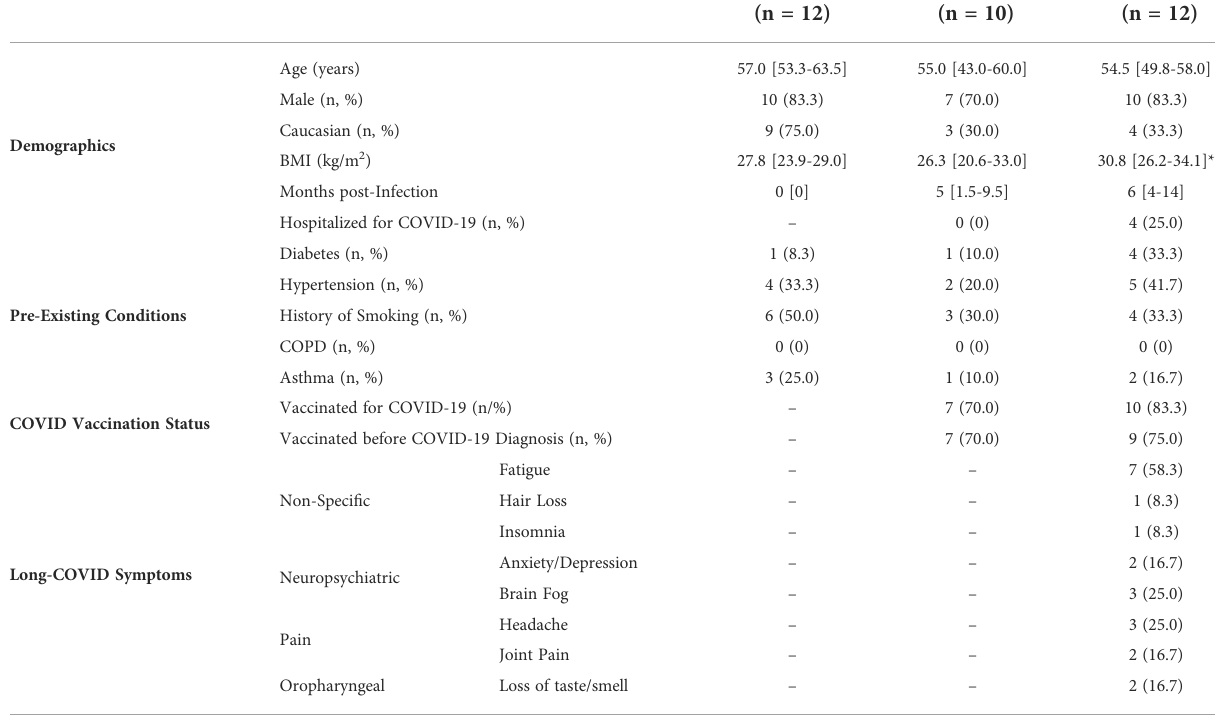
TABLE 1 Demographics and Pre-existing Conditions of naive participants (NP), no residual symptoms (NRS), and pulmonary PASC (PPASC)